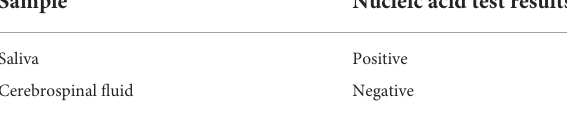
TABLE 2 The result of polymerase chain reaction of rabies